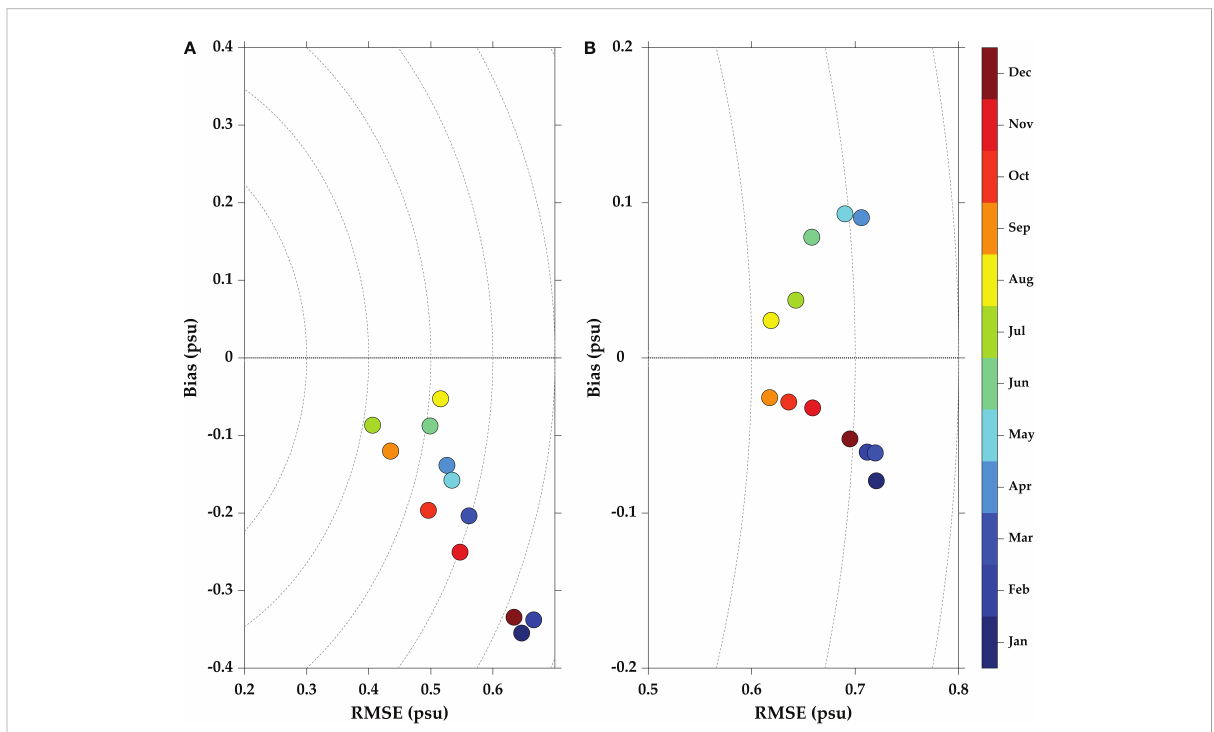
FIGURE 5 Scatter diagrams of root mean square error (RMSE) and bias between sea surface salinity in (A) Aquarius (August 2011 – June 2014), (B) Soil Moisture Active Passive (SMAP) (April 2015 – August 2020), and Argo salinity in the Northwest Paci fi c. Colors represent the months of the matchups from 0°N to